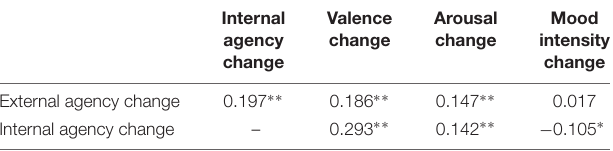
TABLE 2 | Correlations between agency change variables and affective change